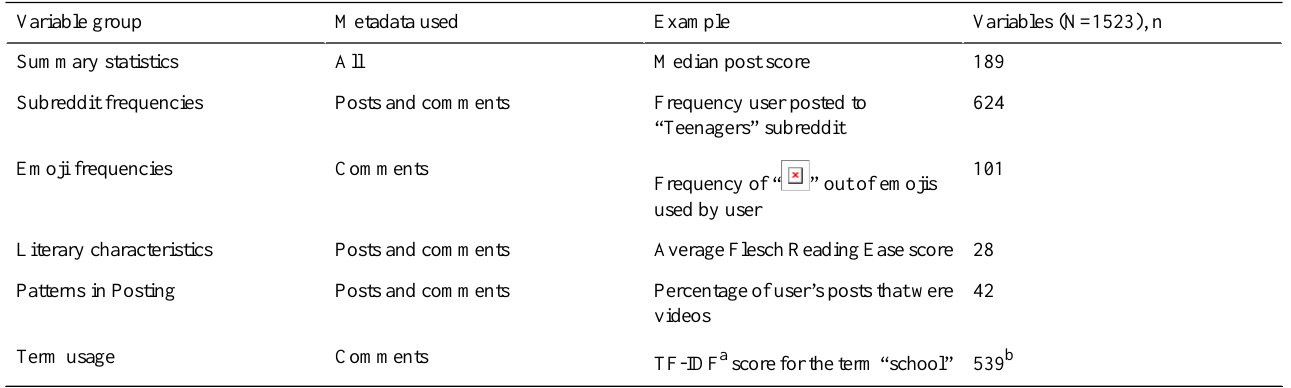
Table 2. Variables for modeling age of Reddit users in the training set derived from the comment, post, and user data collected for users whose ages were confirmed by manual